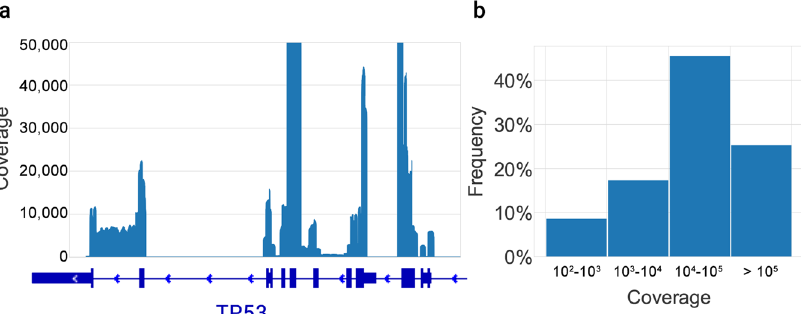
Fig. 2 Coverage of consensus reads across the TP53 gene. a Coverage pro fi le, aligned with a schematic representation of the TP53 gene. The bold blue boxes indicate the exons. The Y-axis was limited to 50,000× coverage. b Frequency of coverage grouped by